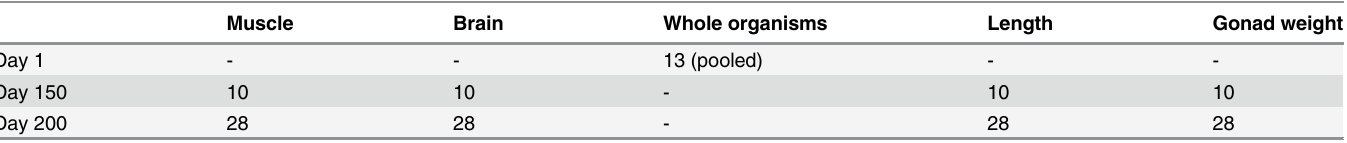
Muscle and brain tissues could not be analyzed separately for larval fi sh, nor could total. Different tissues were sampled at different time points. — indicates that the sample is not